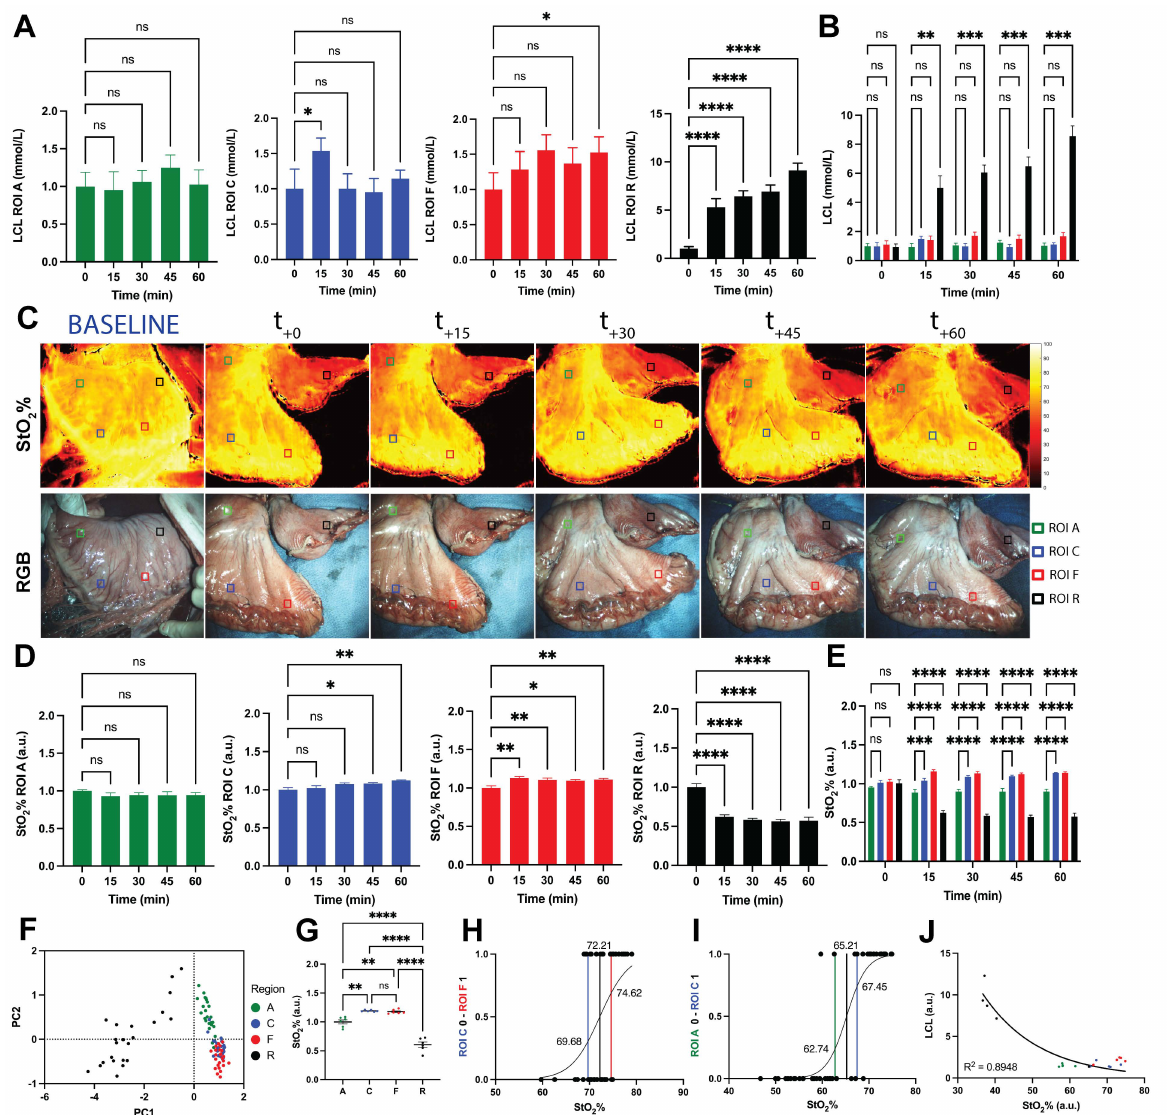
Figure 4. LCLs and StO 2 % quantification and analysis. Different colors indicate different ROIs: green (ROI-A), blue (ROI C), fundus (ROI-F), and black (ROI-R). ( A ) Evolution of LCLs for single ROIs. Only the removed region showed statistically significantly higher values of LCLs for each time point from T15 to T60 when compared to T0; the corpus showed this relationship for T0 vs. T15 and the fundus for T0 vs. T60. Data were normalized for T0 of ROI-A. ( B ) LCL comparison between ROIs. After gastric conduit formation, the removed region showed statistically significantly higher values of LCLs when compared to the other gastric regions. Data were normalized for T0 of ROI-A. ( C ) SSOP images showing StO 2 % of the gastric conduit and the removed region from baseline to T60, and correspondent true color (RGB) images. ( D ) Oxygenation trends for each region of interest during the full ischemic period with a non-constant sampling rate. Between T0 (when the GC is complete) and T15, the sampling rate is around 10 s to monitor the dynamics of tissue perfusion, whereas for t = − 5 min (baseline) and T30, T45, and T60, a single point was sampled. Data were normalized for T0 of ROI-A. ( E ) Evolution of StO 2 % for single ROIs. StO 2 % increased along time in the corpus (T45 and T60) and fundus (T15, T30, T45, and T60). Instead, as expected, StO 2 % values at T15, T30, T45, and T60 were lower than T0. Data were normalized for T0 of ROI-A. ( F ) Principal component analysis of the ROIs. The variables selected are LCL and StO 2 % and the label used is the ROI (A, C, F, R). ROI-R represents a separate cluster from the other ROIs. Principal Component (PC)1 and PC2 contribute to 94.83% of the variance. ( G ) StO 2 % comparison between ROIs. After GC formation, the removed region showed lower StO 2 % values than other gastric districts. Instead, StO 2 % of the antrum appeared lower when compared to the corpus and fundus. Data were normalized for T0 of ROI-A. ( H ) Simple logistic regression analysis between ROI-A and ROI-F. ( I ) Simple logistic regression analysis between ROI-A and ROI-C. ( J ) Pearson’s correlations between LCL and StO 2 %. Higher